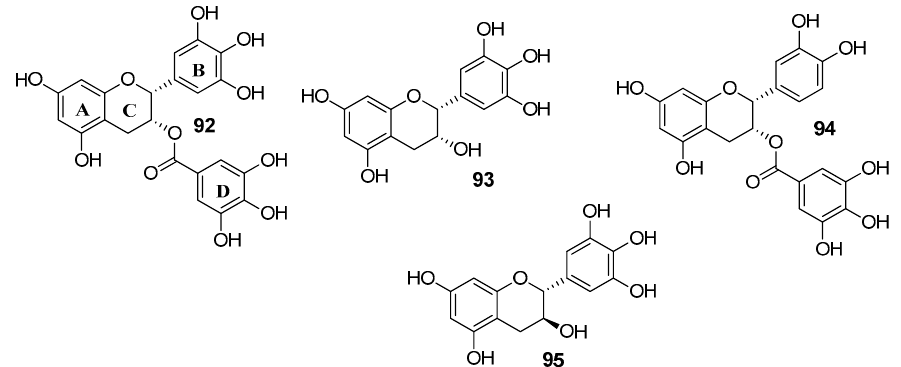
Figure 12. Structures of catechins: ( − )-epigallocatechin gallate ( 92 ), ( − )-epigallocatechin ( 93 ), ( − )- epicatechin gallate ( 94 ) and (+)-gallocatechin ( 95 ).